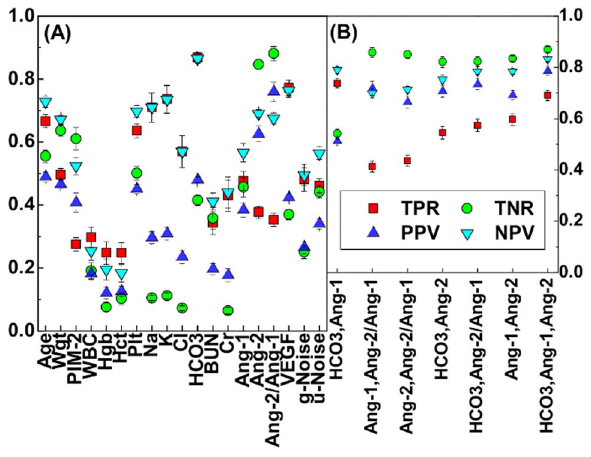
Figure 3. Prediction measures for single and pairs of biomark- ers from the Support Vector Machine (SVM). True positive rate (TPR), true negative rate (TNR), positive predictive value (PPV), and negative predictive value (NPV) are shown for (A) each single biomarker and (B) all pairwise combinations of Ang-1, Ang-2, HCO 3 and Ang-2/ Ang-1. The prediction measures for the CCA-selected optimal subset of biomarkers at k ~ 3 (Ang-2, Ang-1, and HCO 3 ) are also shown in (B) for